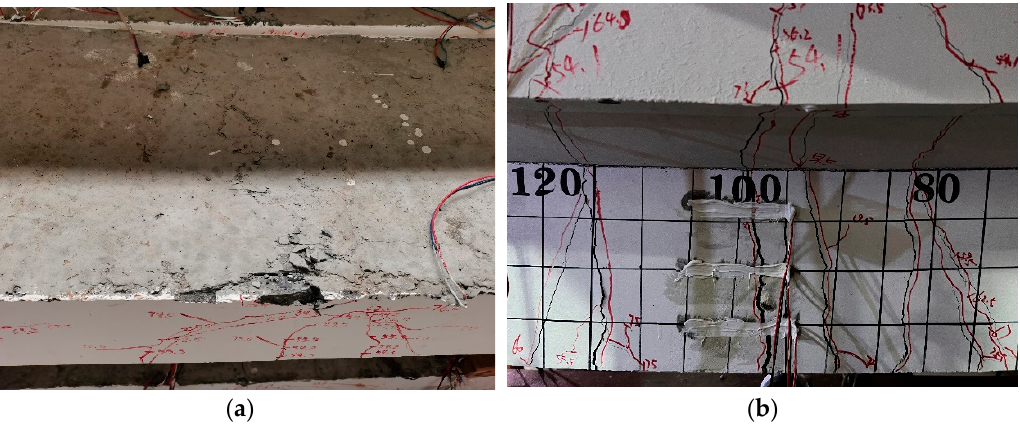
Figure 6. The failure mode of test beams. ( a ) Roof concrete crushing; ( b ) Main crack in mid-span. The maximum crack width of the WS beam is 2.02 mm, and the maximum crack widths of ZSS1, ZSS2 and ZSS3 are 6.44 mm, 6.35 mm and 7.09 mm, respectively, which are 3.19 times, 3.14 times and 3.51 times, respectively, that of the WS beam. The results indicate that the prefabricated crack in mid-span significantly weakens the cross-section stiffness of the test beam. In addition, the height of the prefabricated crack in the ZSS2 beam is 60 mm, and the concrete in the tension zone will exit the work earlier, resulting in the tension steel bar bearing the tensile stress induced by the load earlier. Therefore, the maximum crack width of the ZSS2 beam is slightly smaller, compared with the ZSS1 beam. As the diameter of the steel bar at the ZSS3 beam decreases, the stress of the steel bar is greater under the same load, and its elastic deformation also increases. Therefore, the maximum crack width of the ZSS3 beam increases by 11.7%, compared with the ZSS2 beam. Compared with the mid-span pre-cracked test beam, the prefabricated cracked beam at the l /4 position has little effect on the stiffness of the test beam. The maximum crack widths of DSS1, DSS2 and DSS3 are 1.83 mm, 1.91 mm and 2.63 mm, respectively, which are 0.94 times, 0.95 times and 1.31 times, respectively, that of the WS beam. As the height